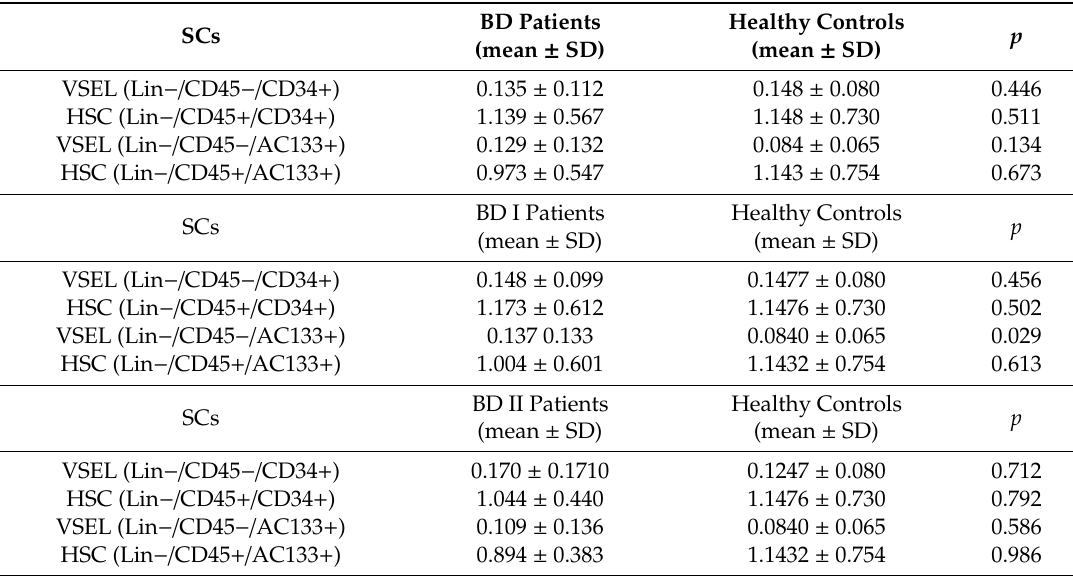
Table 2. The levels of stem cells in patients with BD and healthy